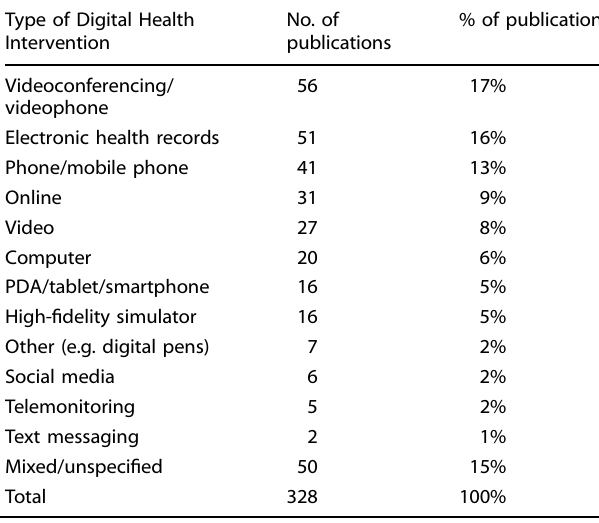
Table 1. Types of DHIs reported in publications included in 21 systematic